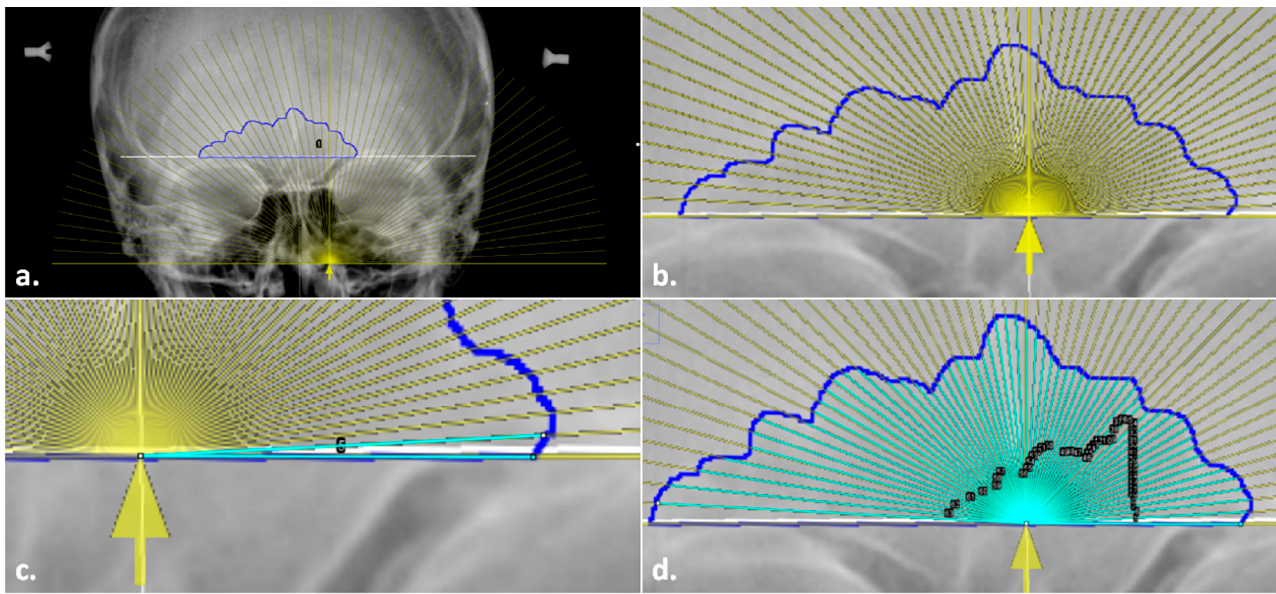
Figure 5. Placing the overlay in the modified steps in the Total Difference Method: ( a ) insertion of a semi-transparent overlay (yellow) onto the radiograph with the sinus outline and origin marked; ( b ) alignment of the overlay baseline and origin arrow (yellow) with the sinus outline (blue) and midline (underlying white solid line); ( c ) preliminary angle drawn at 3°; ( d ) completed angles with black ROI Manager numbered labels for editing, if required.